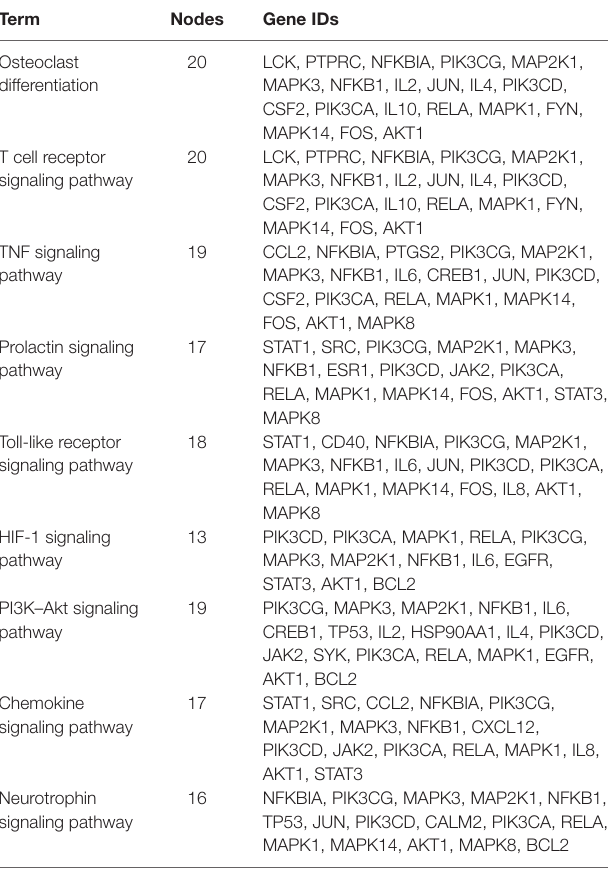
TABLE 2 | The major hubs of the Huayu-Qiangshen-Tongbi–rheumatoid arthritis (HT–RA) protein–protein interaction (PPI) network and their frequently associated